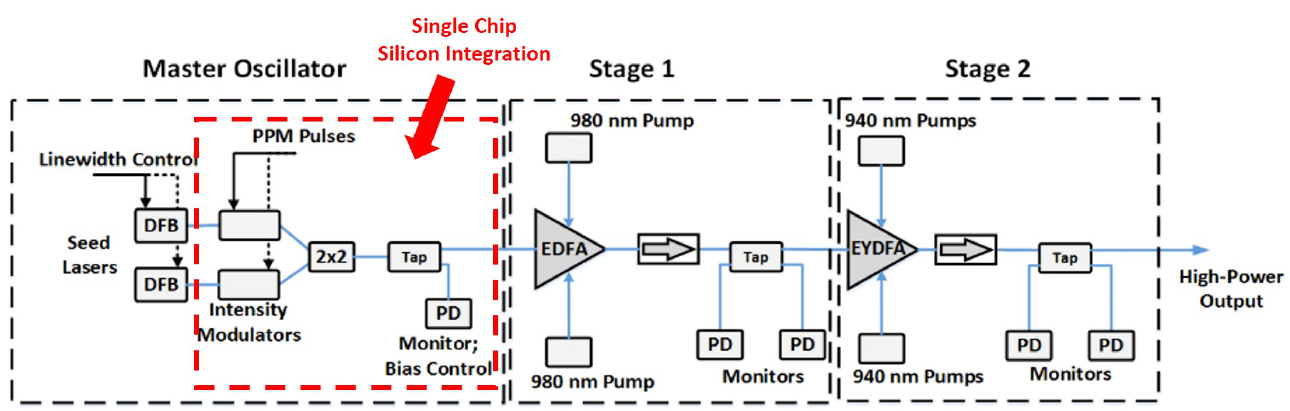
Figure 2. A schematic of an LTA showing the initial modulation stage followed by two amplification stages to boost the optical signal (after [26]). Highlighted in red is the subsystem that can be fully replaced by a silicon